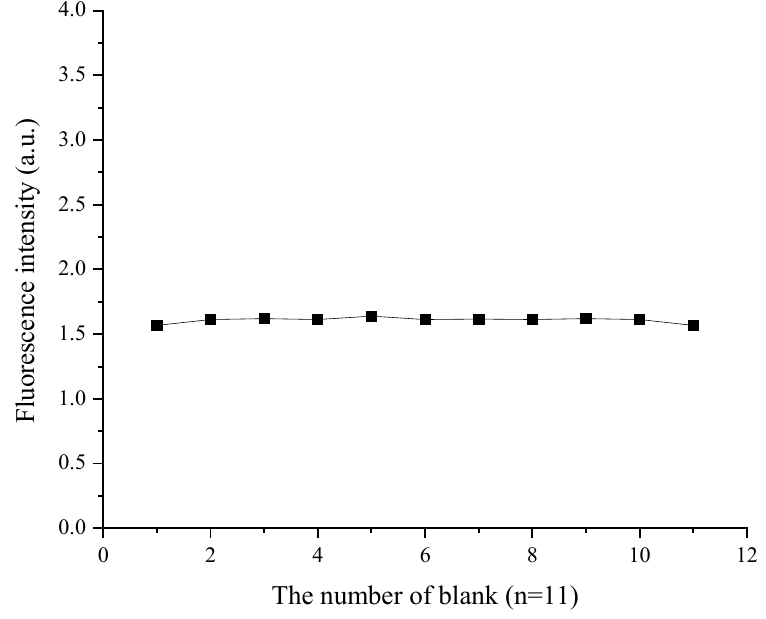
Figure 8. Fluorescence intensity measurement of pure probe solution (11 times) .